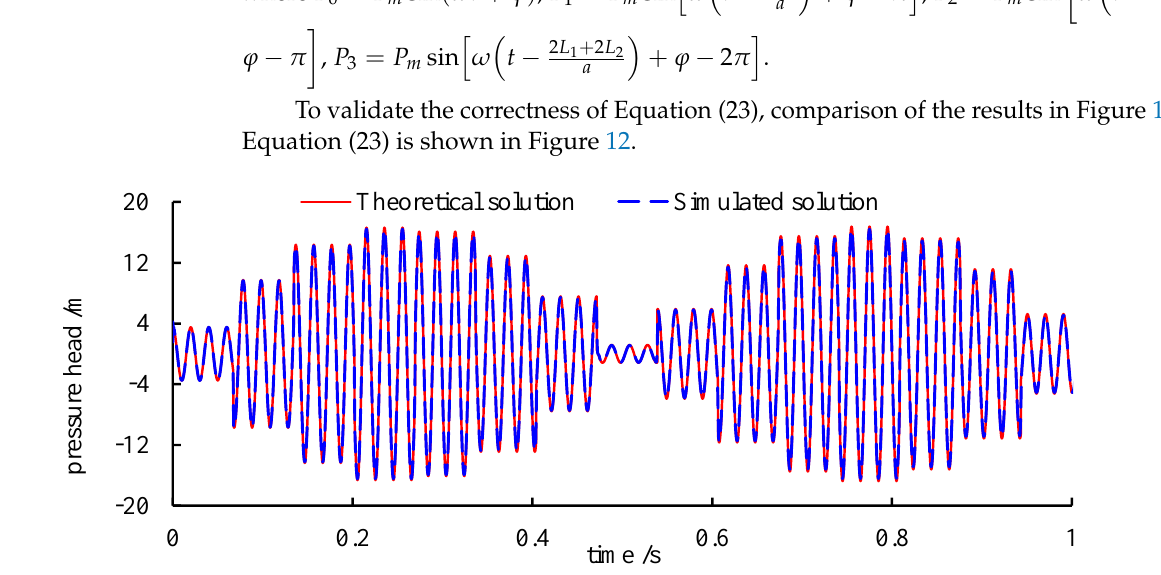
Figure 12. Comparative results of the pressure oscillation.